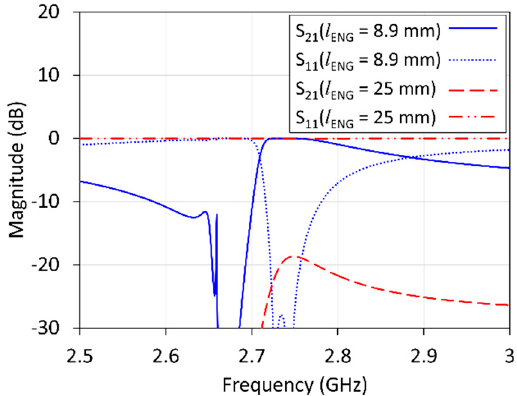
Figure 7. Theoretically predicted TE 10 mode S-parameters for the structure of Figure 2 using anisotropic permittivity and permeability values of Figure 5 for the two cases of l ENG when l MNG is 25 mm. (In color.).